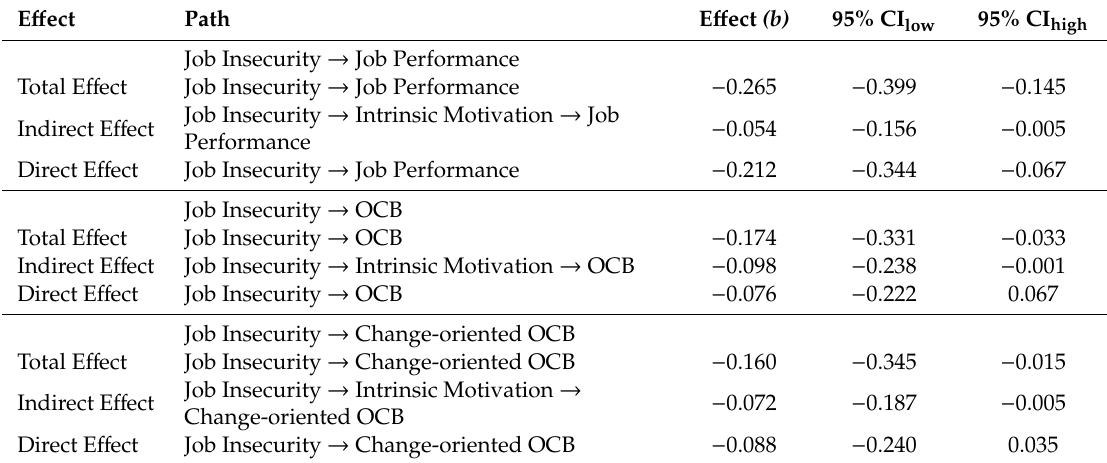
Table 3. E ff ects for Mediation